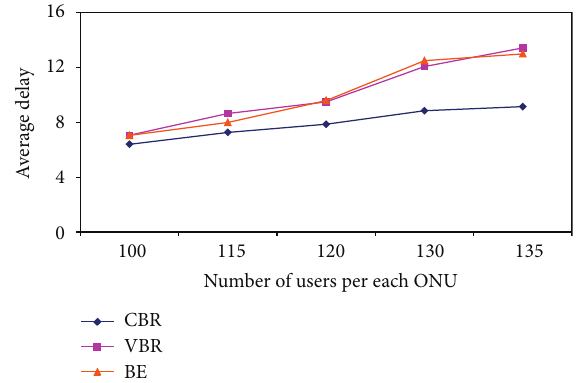
Figure 11: Change in delay due to increase in the number of users.